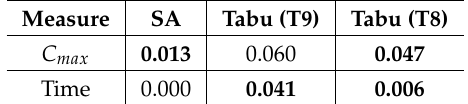
Table 5. Results of Wilcoxon test for the small problems (best results are in